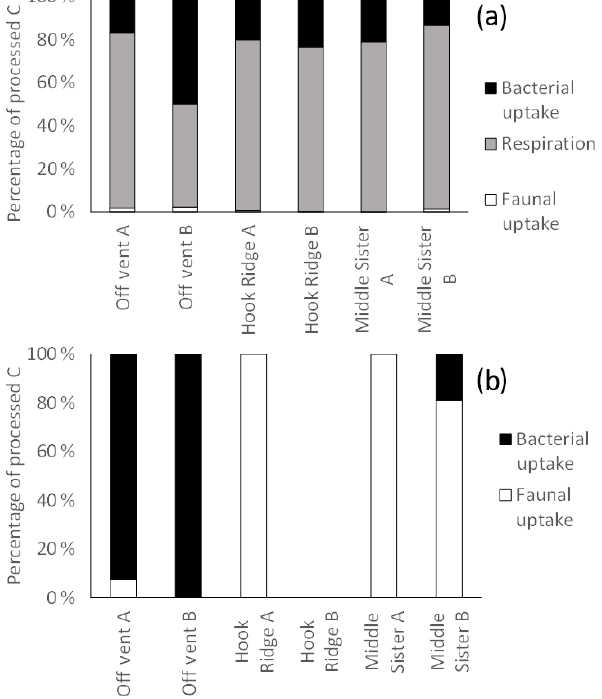
Figure 7. Distribution of biologically processed C between pro- cesses for the (a) algae addition experiments and (b) bicarbonate addition experiments. The absence of data represents the combina- tion of the lack of sample and an undetectable faunal 13 C